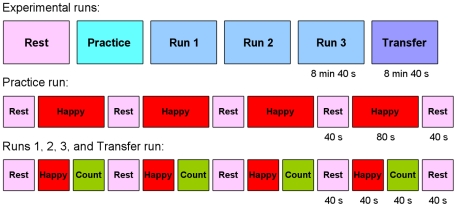
Protocol for the Real-time fMRI Neurofeedback Experiment.The experimental procedure consisted of six runs each lasting 8 min 40 sec. During the Rest run, the participants were instructed to rest. During the Practice run, the subjects were given the opportunity to become comfortable with the rtfMRI neurofeedback procedure. During Runs 1, 2, and 3, the participants underwent rtfMRI neurofeedback training consisting of alternating blocks of Rest, Happy, and Count conditions, each lasting 40 seconds. During the Transfer Run, the subjects were instructed to perform the same task as during the neurofeedback training, but neurofeedback information (bars, number) was not be provided.